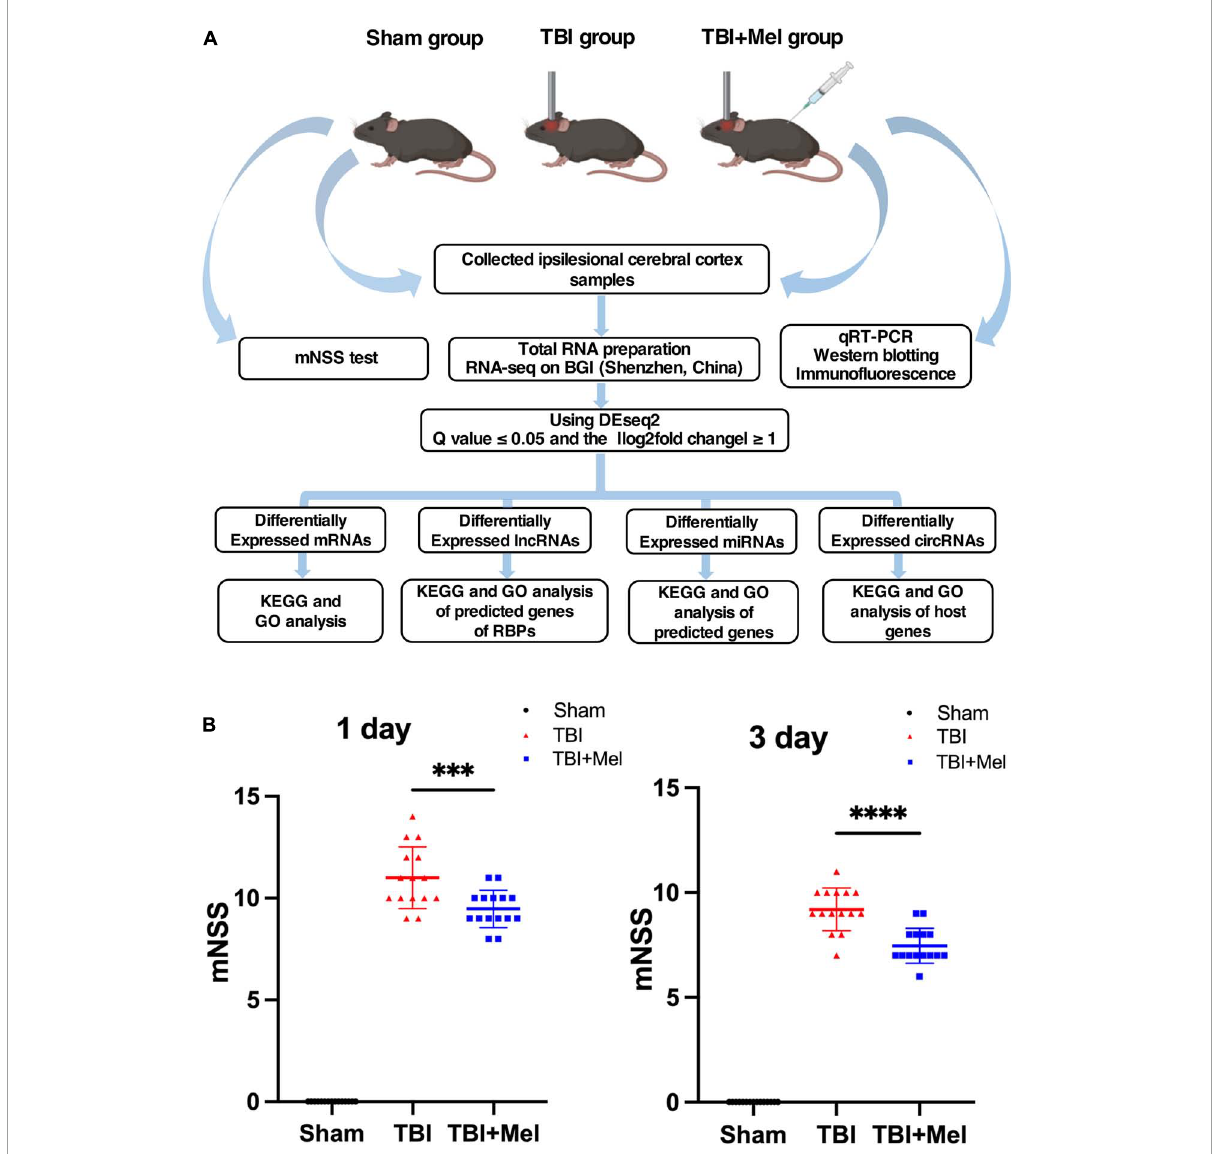
FIGURE1 Experimental design scheme and the neural function assessment. (A) Study flow chart. (B) The neurological function of mice was assessed by the mNSS; the data were presented using mean ± SD, *** p < 0.001 TBI + Mel vs. TBI, and **** p < 0.0001 TBI + Mel vs. TBI, n = 15, one-way ANOVA followed by Tukey’s